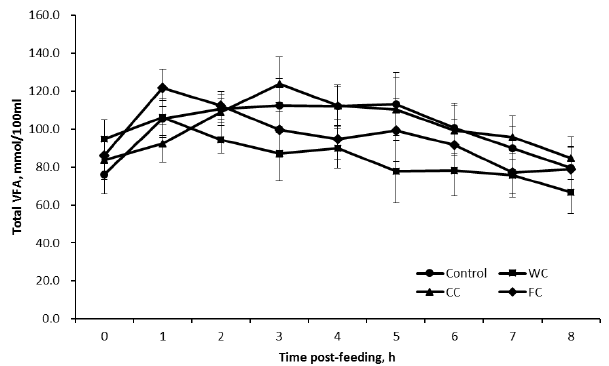
Figure 4. Changes in ruminal volatile fatty acid of Holstein steers fed total mixed ration (TMR) as a basal. Treatments were TMR only (Control, ●), TMR with whole corn grain (WC, ■), TMR with coarsely ground corn grain (CC, ▲) and TMR with finely ground corn grain (FC, ◆ ), respectively.